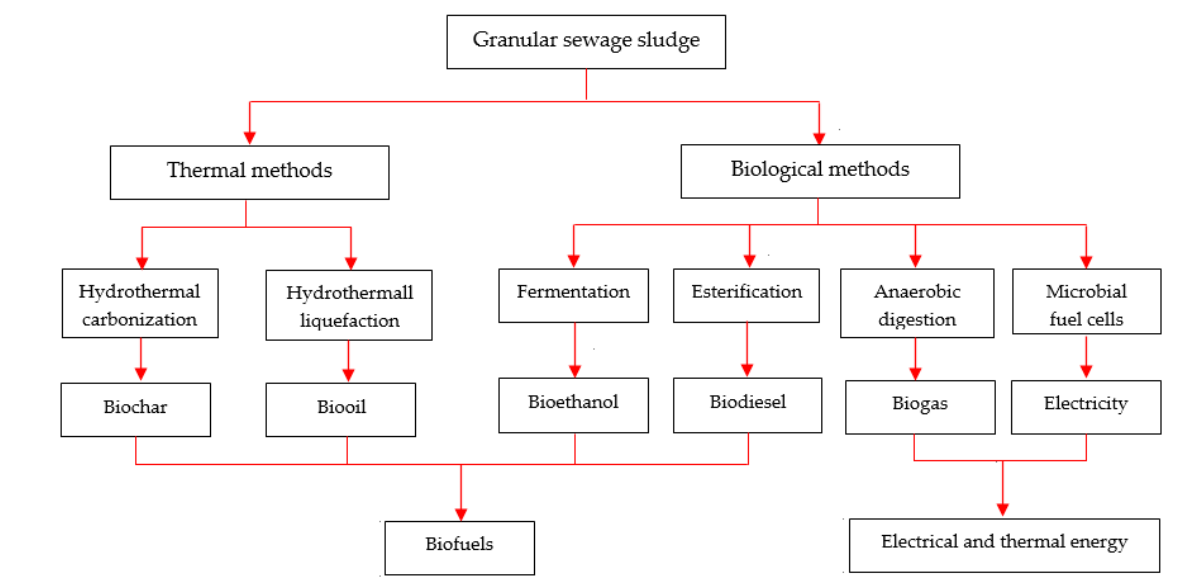
Figure 8. Applications of granular sludge in energy generation (inspired by